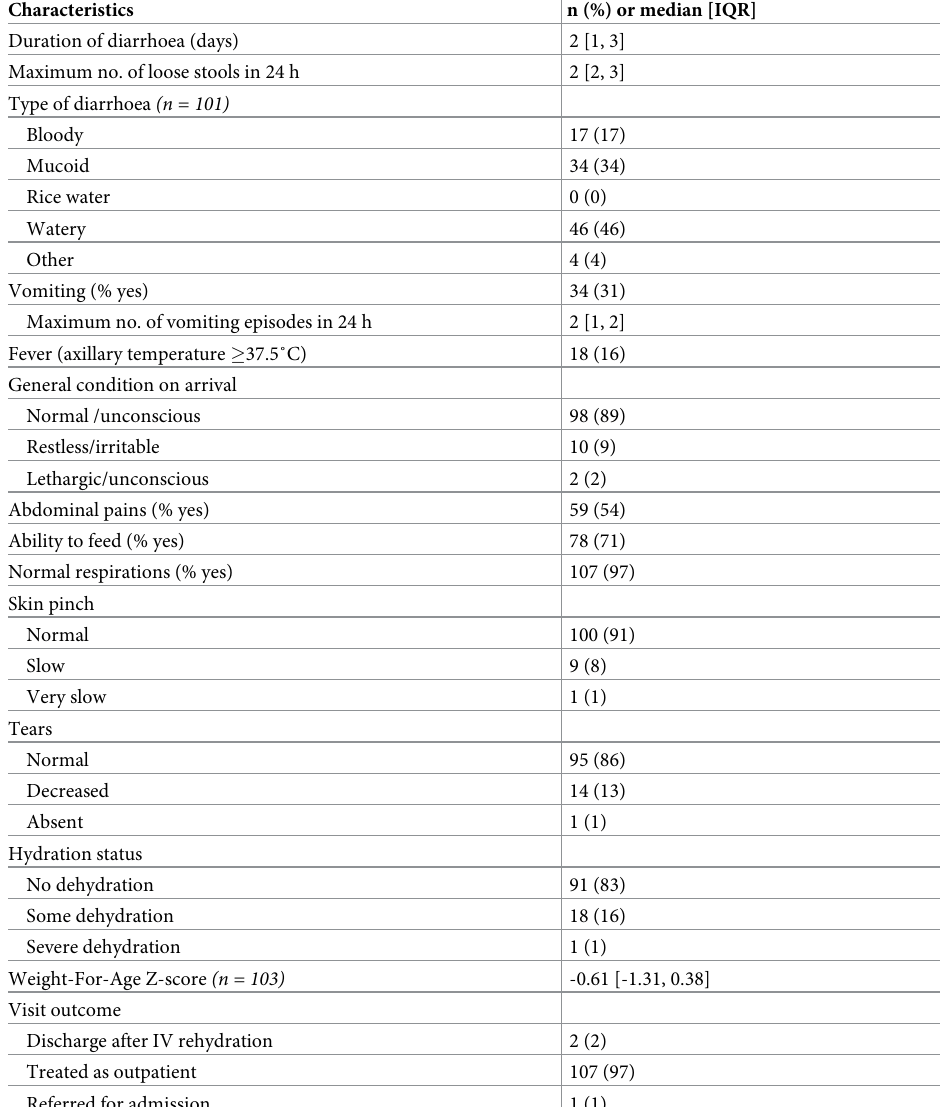
Table 3. Clinical characteristics of diarrhoea episodes (n = 110).